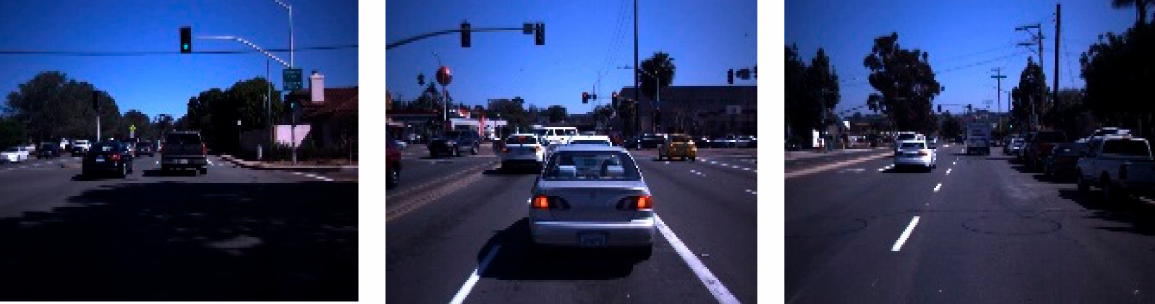
Figure 2. Example results of